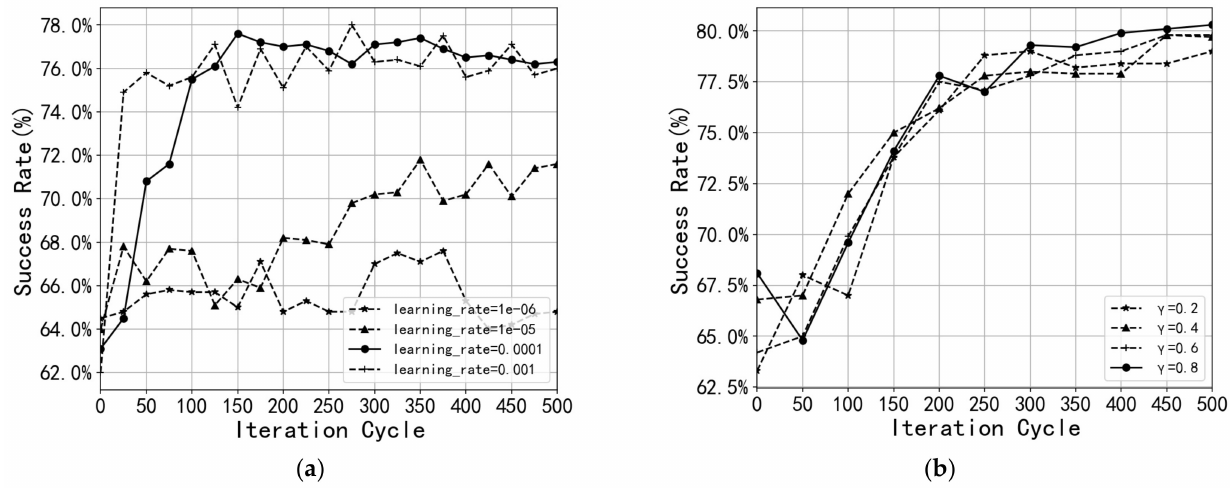
Figure 4. Evaluation under different parameters of training. ( a ) Task successful rate under various learning rates, and ( b ) task successful rate under various attenuation factors.